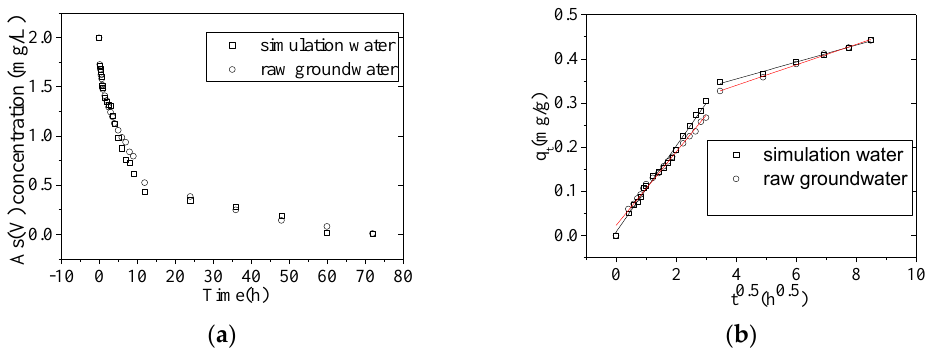
Figure 7. Effect of multiple interfering ions on As(V) adsorption. ( a ) Effect of multiple coexisting ions Figure 7. E ff ect of multiple interfering ions on As(V) adsorption. ( a ) E ff ect of multiple coexisting ions on the removal of As(V) as a function of time. ( b ) Intraparticle di ff usion model fit for the removal of on the removal of As(V) as a function of time. ( b ) Intraparticle diffusion model fit for the removal of As(V) by NZVI / AC in the presence of multiple interfering ions (conditions: C 0 = 2.0 mg / L, 150 rpm, As(V) by NZVI/AC in the presence of multiple interfering ions (conditions: C 0 = 2.0 mg/L, 150 rpm, 20 × 40 mesh particle size, t = 72 h, T = 298 K, adsorbent dosage = 1.5 g / L, pH = 7.58 (i.e., natural pH), 20 × 40 mesh particle size, t = 72 h, T = 298 K, adsorbent dosage = 1.5 g/L, pH = 7.58 (i.e., natural pH), − − coexisting ions = PO 3 , SiO 2 ). 4 coexisting ions = PO 43− , SiO 42− ). 4